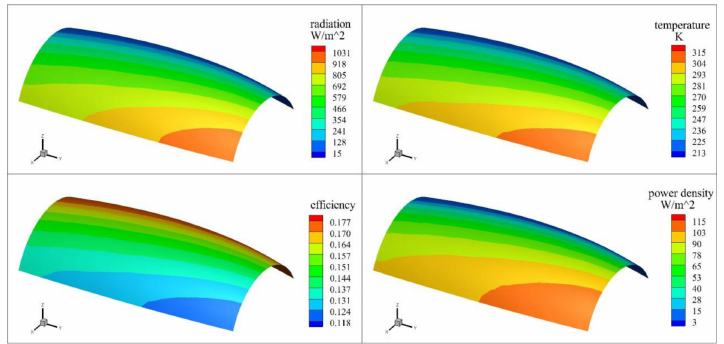
Figure 7. Thermal and energy characteristics of the solar array on the winter solstice at 8:30.